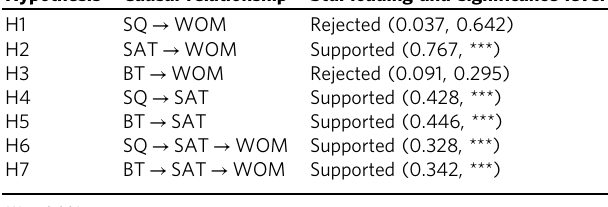
Table 8 Hypotheses results. Hypothesis Causal relationship Std. loading and signi fi cance